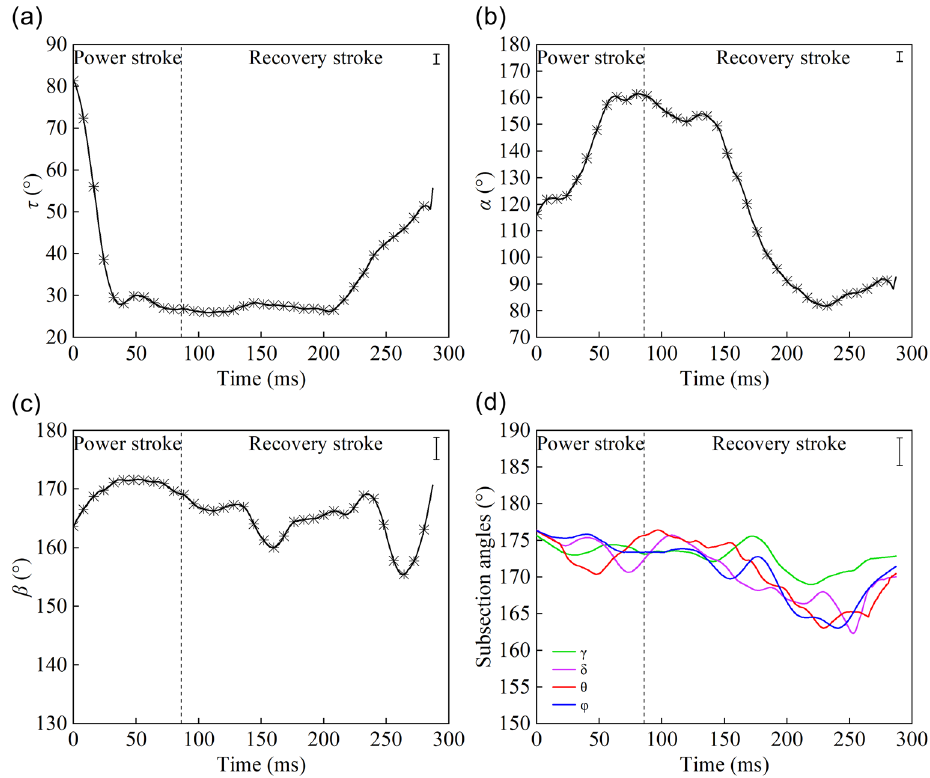
Figure 6. Curves of the joint angle changes with time during the retreating motion: (a) the curve of angle τ , which decreased rapidly during the power stroke and increased slowly during the recovery stroke; (b) the curve of angle α ; (c) the curve of angle β ; (d) curves of the subsection angles, the angle β and the subsection angles remained steady (SIMI Motion 2007, www. simi. com, the carrier of the software is a